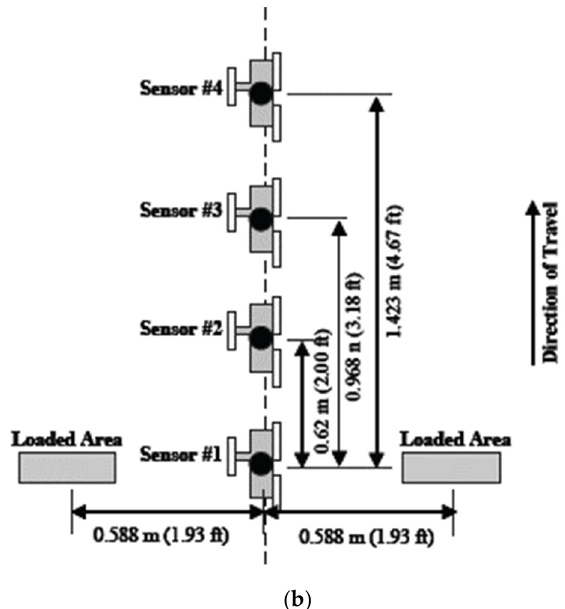
Figure 1. General description of the RDD: ( a ) A sideview of the RDD, ( b ) a typical RDD rolling sensor array (after Bay and Stokoe [15]).